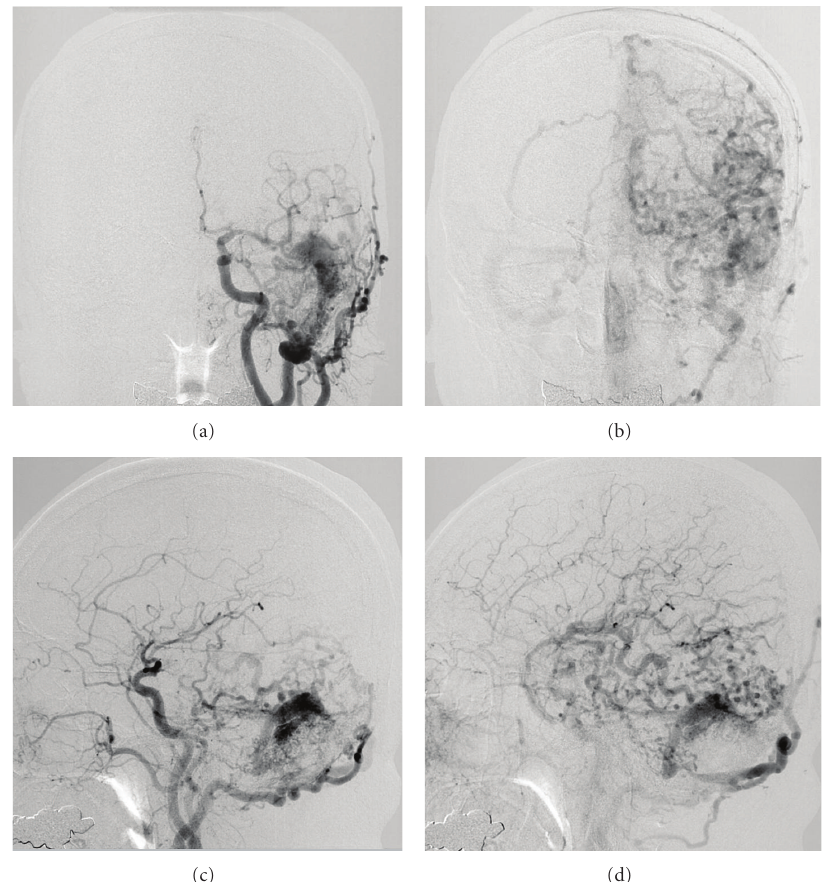
Figure 1: (a) A DAVF in the left transverse-sigmoid sinus was shown on the arterial phase of the left common carotid artery angiogram (anteroposterior view). (b) Numerous draining cortical veins of the AVF indicating severe venous reflux and congestion were demonstrated on the venous phase of the angiogram (anteroposterior view). (c) On the arterial phase of the lateral view, a DAVF had many feeding arteries, meningeal branches from the external carotid artery, cortical venous reflux, and the isolated left transverse-sigmoid sinus as drainer [2, 3]. (d) Note the cortical venous congestion in the wide area of the left cerebral hemisphere [2, 3].